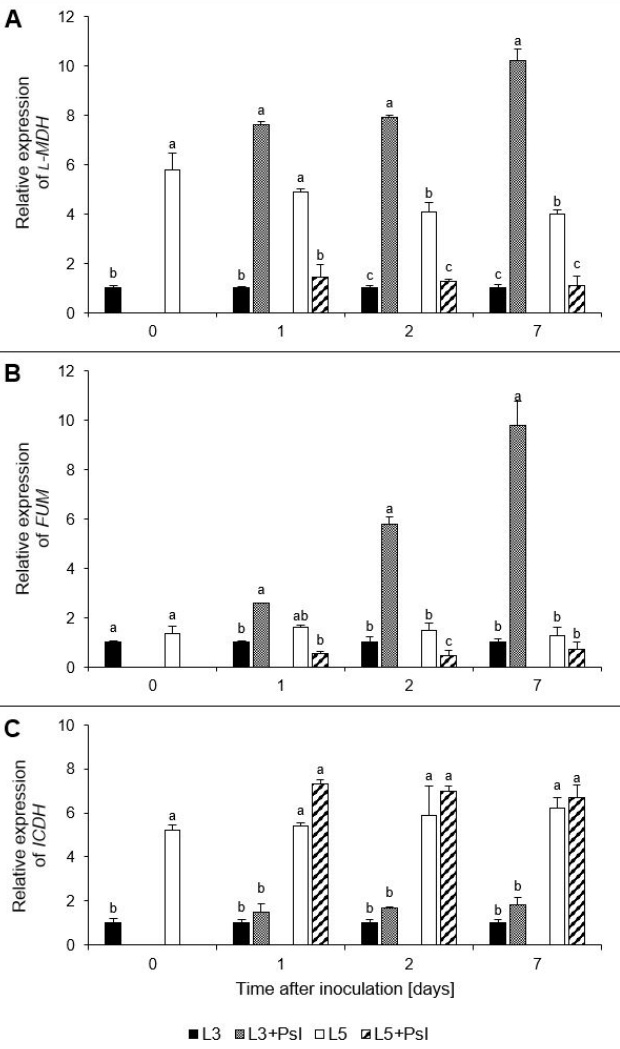
Figure 6. Relative expressions of ( A ) L -malic acid dehydrogenase ( L -MDH ), ( B ) fumarase ( FUM ), and ( C ) isocitrate dehydrogenase ( ICDH ) genes in cucumber leaves after Psl infection. Values are means of four replicates (±SD). Different letters (a–c) indicate significant ( p ≤ 0.05) differences between experimental variants at a given time point.